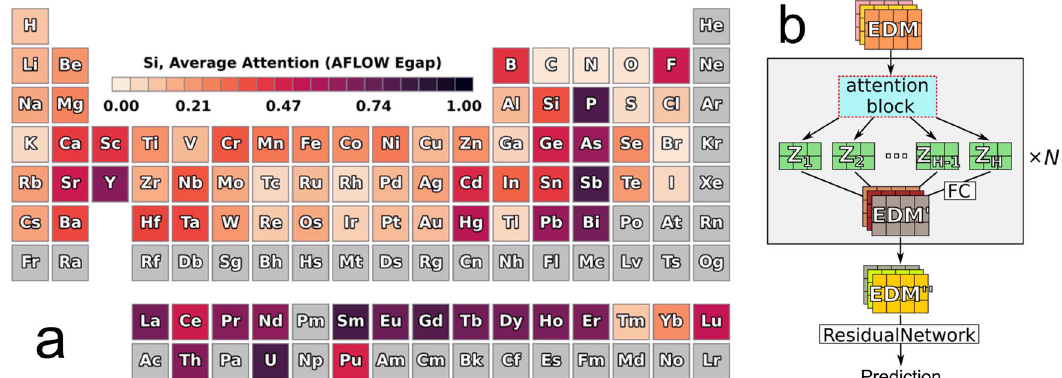
Fig. 14 CrabNet heat map explanation example and model architecture. a An element importance heat map from CrabNet. The colors indicate the average amount of attention that Si pays to other elements. This heat map shows that its corresponding attention head (i.e., the fi rst attention head from the fi rst attention layer of CrabNet) attends to common n-type dopants. Here CrabNet is trained with the a fl ow_Egap dataset 160 in which many compounds contain Si. b Illustration of the CrabNet architecture, which includes the EDM embedding, the encoder (shown in the gray square), and the predictor (ResidualNetwork). The attention block design is shown in Fig. 13. One attention block has multiple attention heads. Z 1 , … , Z H are generated from different attention heads in the same attention layer. FC stands for fully connected layer, which corresponds to a small feed-forward network. × N means that the attention layer is repeated N times to form the encoder network. Figure reprinted from ref. 90 under the CC BY 4.0 license 156